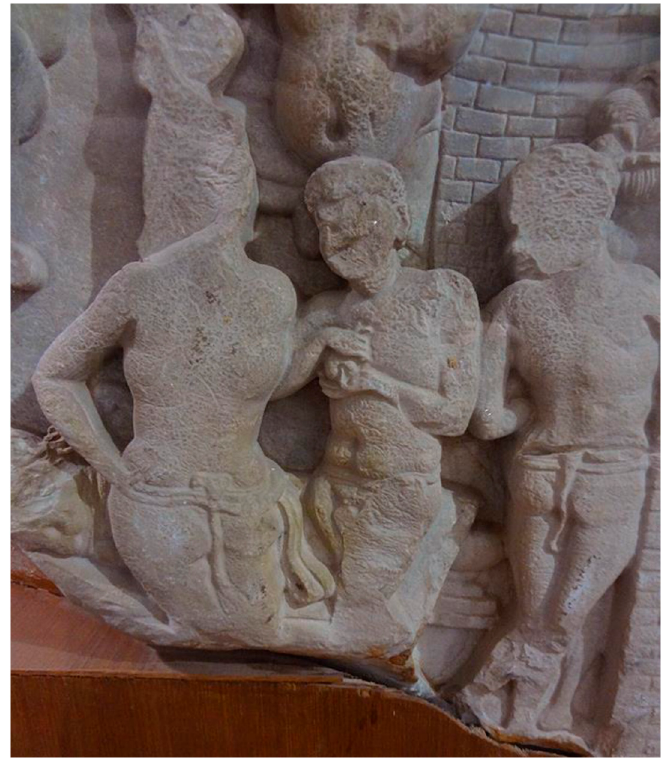
Figure 12. Part of relief no. 75 in Chennai Government Museum © photograph Wojtek Oczkowski.